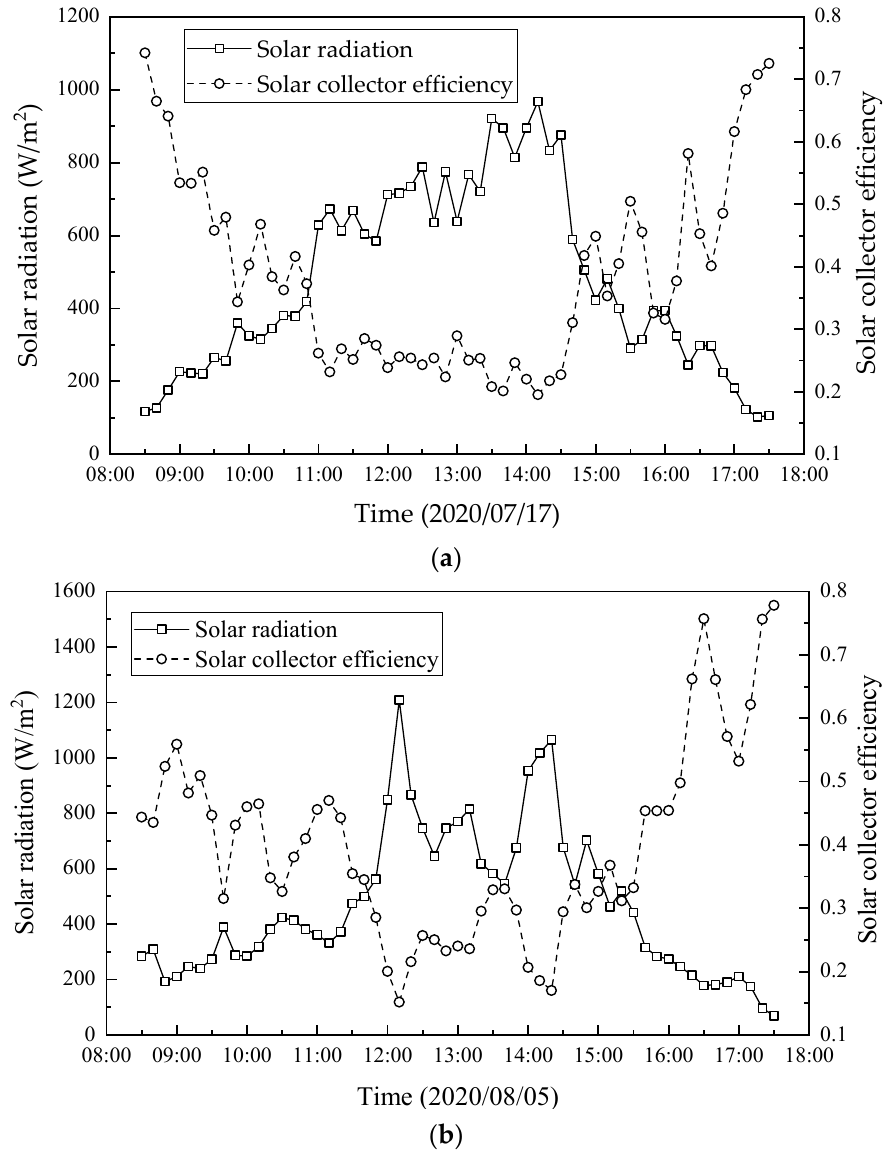
Figure 10. Hourly variation in solar radiation and solar collector e ffi ciency on two days in July and